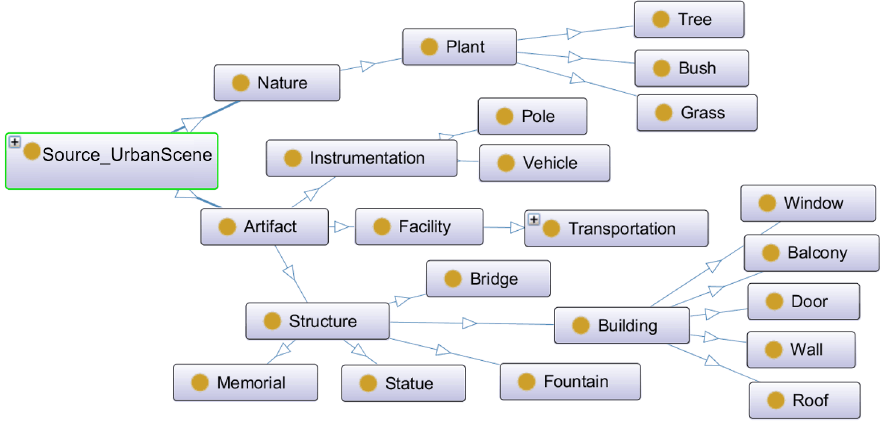
Figure 4. Classification of concepts according to their source or nature.